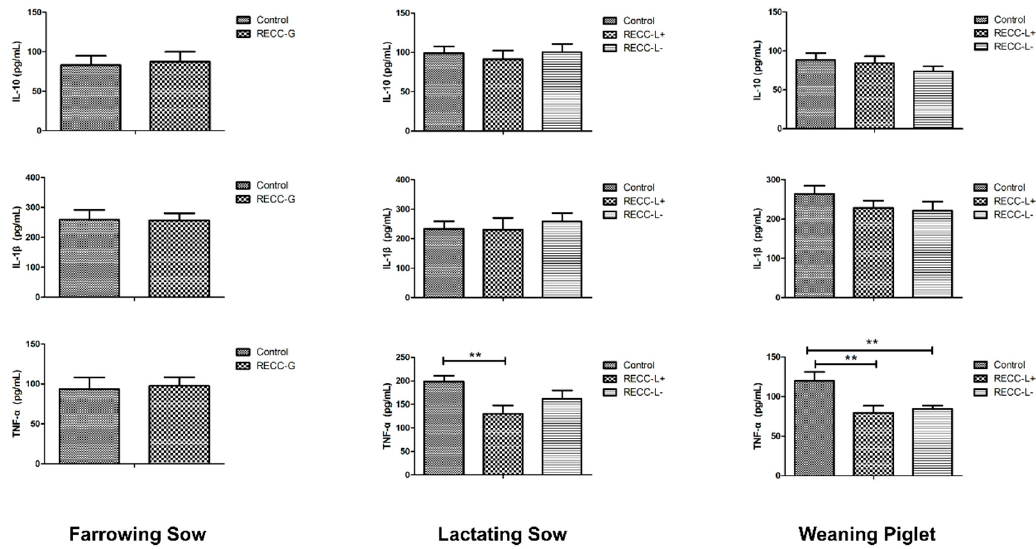
Figure 3. Effect of maternal REE supplementation on plasma inflammatory cytokines of the sows and their piglets. n = 8 per group. Values are mean ± SEM. ** p < 0.01. REE-L+, REE supplied during gestation and lactation. REE-L-, REE supplied only in late gestation.